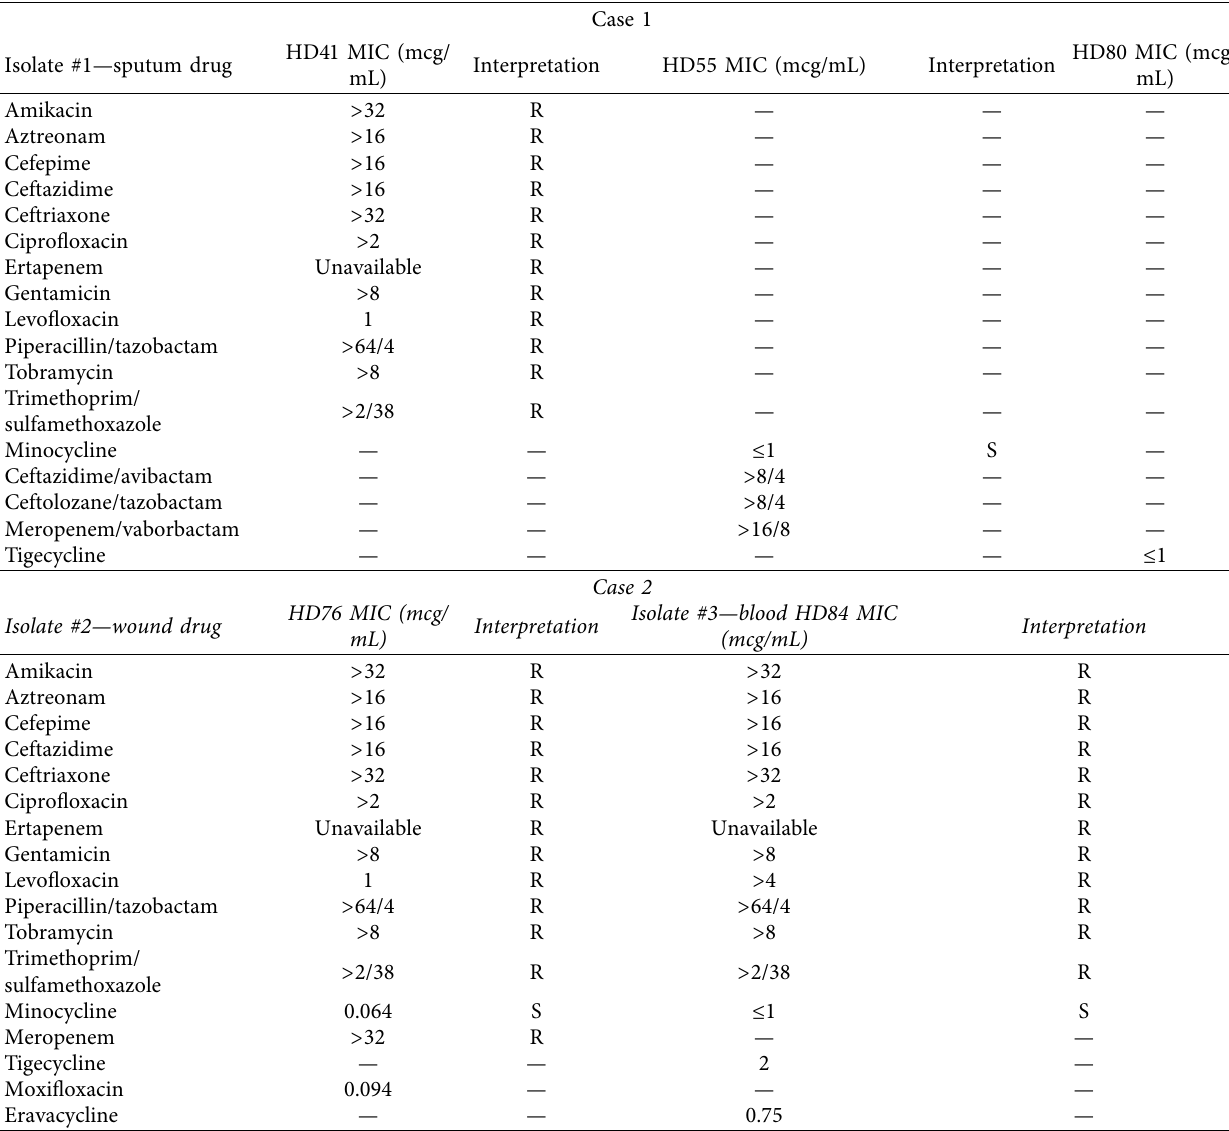
Table 1: Susceptibilities for M. odoratus